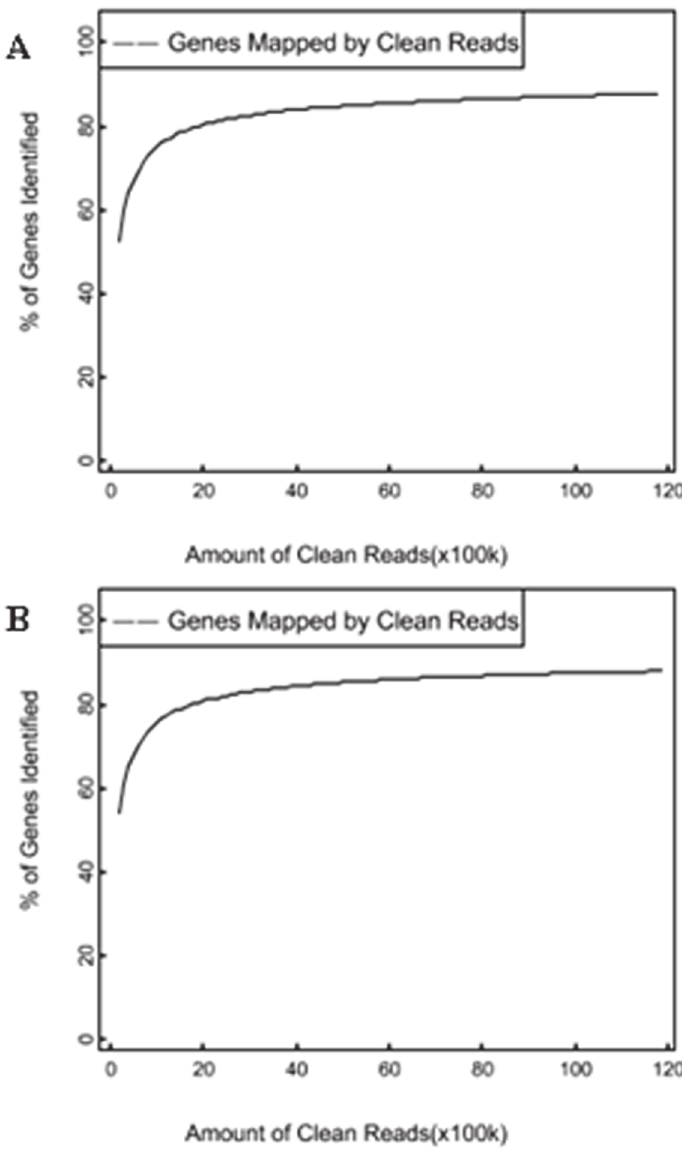
Fig 1. Saturation analyses of Qira black sheep (A) and Hetian sheep (B). The number of detected genes continued increasing as the total number of sequencing reads increased. When the number of reads reaches a certain amount, the number of detected genes almost ceased increasing.